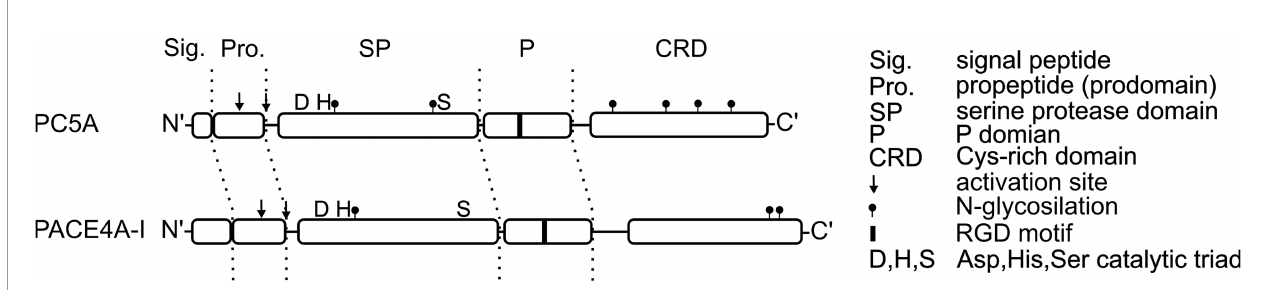
FIGURE 2 | Domain structures of PCSK5 (PC5A isoform), and PCSK6 (PACE4A-I isoform). PC5A is the shorter, secreted isoform of the two main isoforms of PCSK5. PCSK6 (PACE4) has several secreted isoforms. PACE4A-I is considered as the main (canonical) isoform. Two autocatalytic cleavages ( ↓ ) after and within the prodomain are required for activation. The second cleavage is thought to